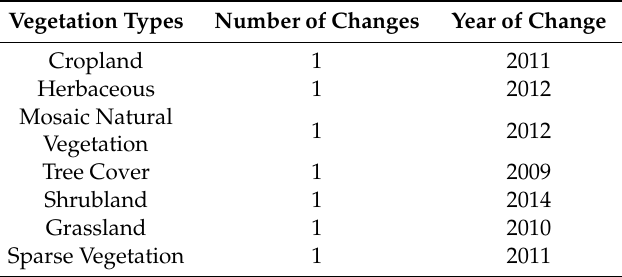
Table 2. Statistics of the negative changes with the largest areas for each vegetation type. Vegetation